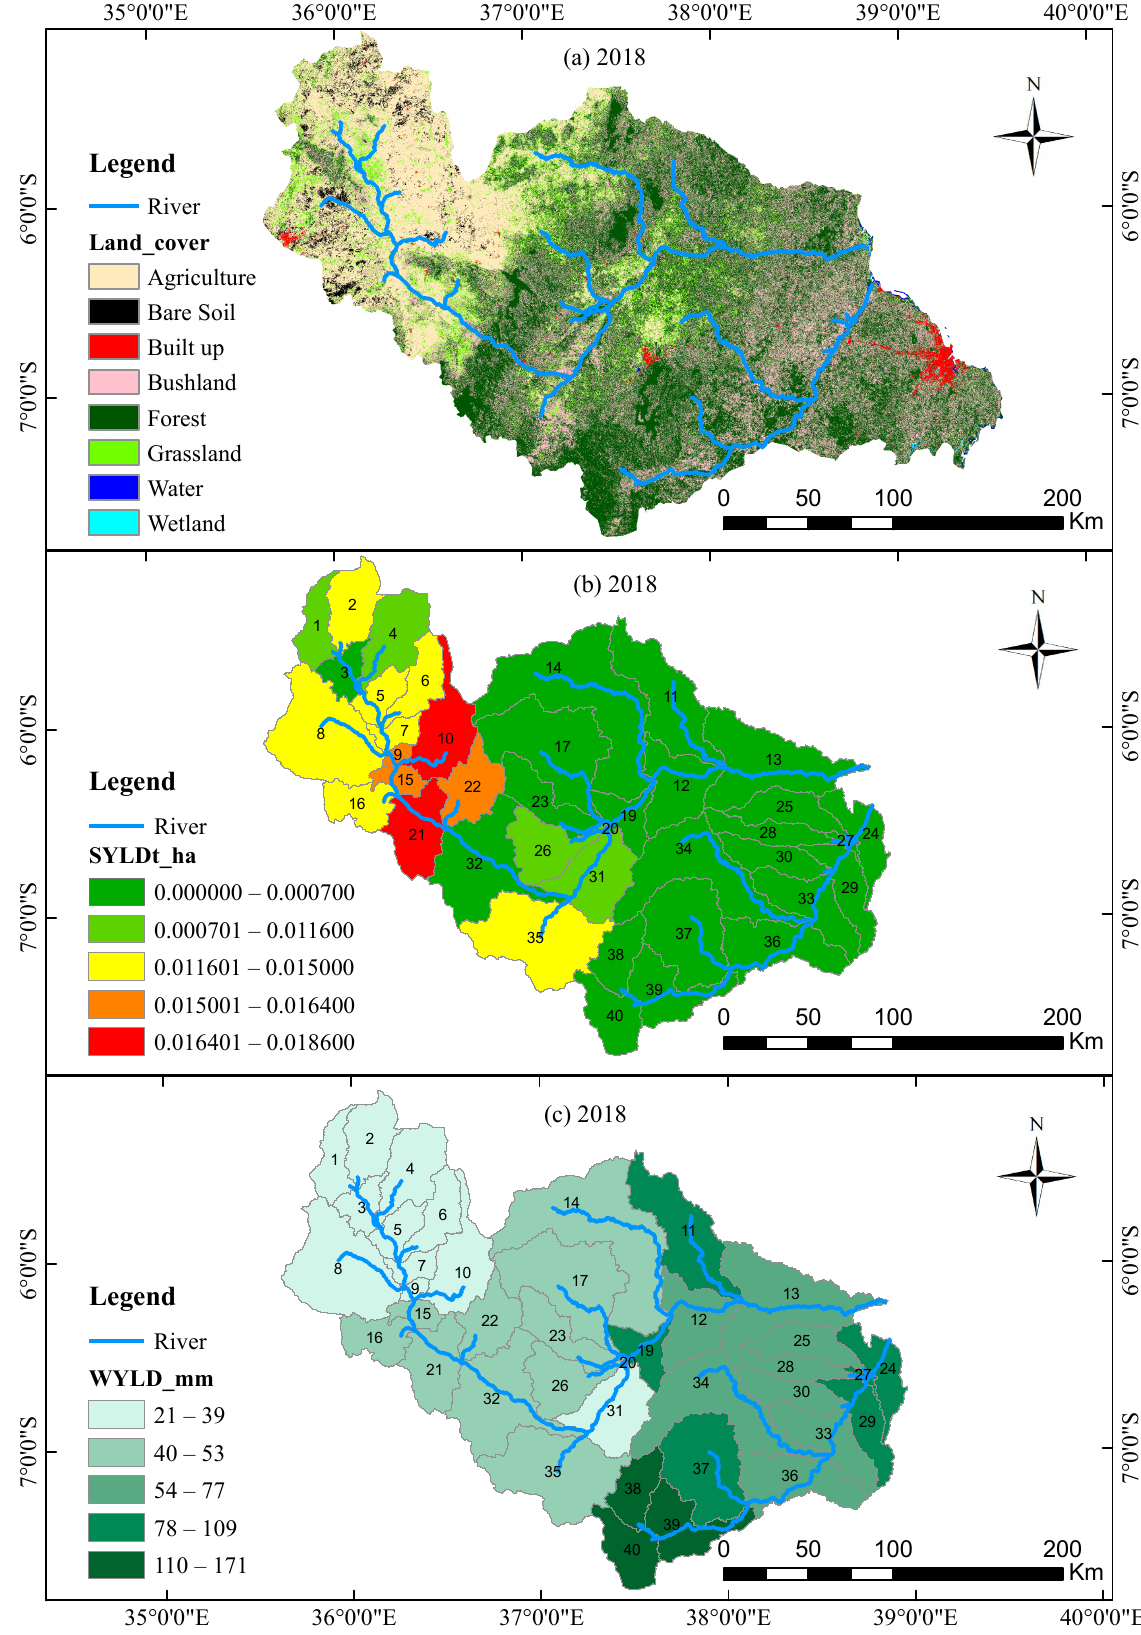
Figure 15. ( a ) The LULC distribution and its associated impacts on ( b ) SYLD and ( c ) WYLD in 2018.